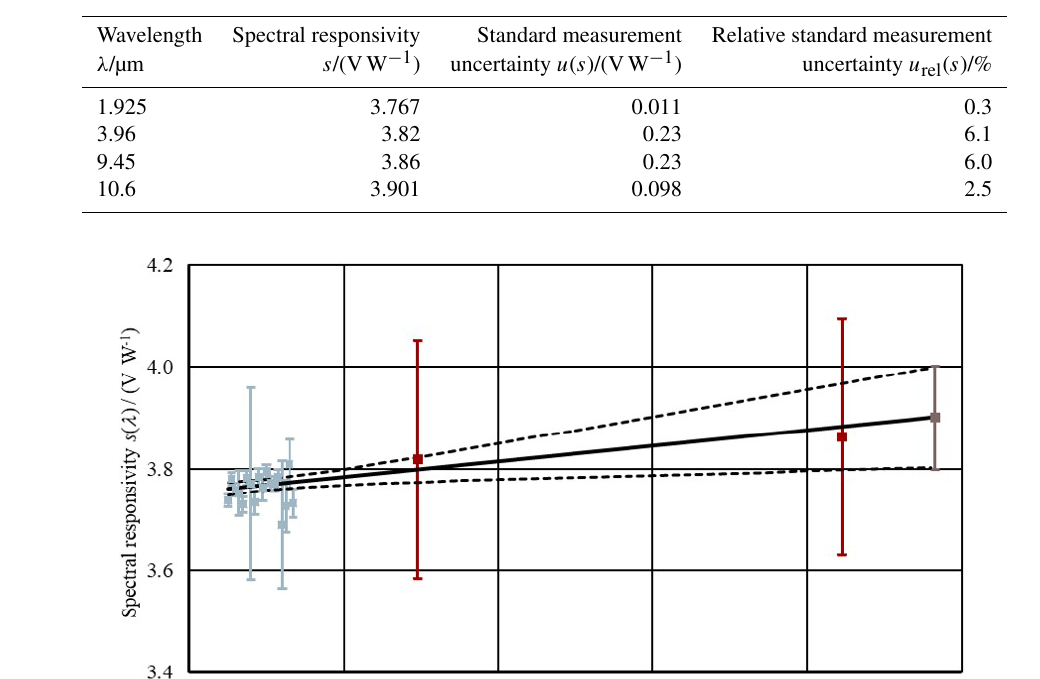
Table 2. Measurements of the spectral responsivity of the TS-76 performed in the MIR.